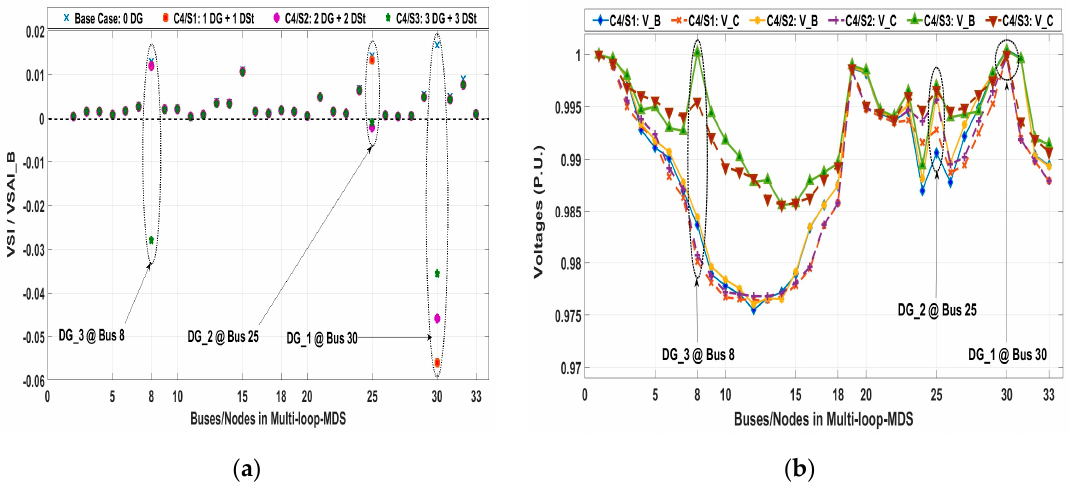
Figure 9. Case 4 for 33-bus MDS: DG (type-1) and DSTATCOM (type-3) equivalent to 0.90 ± 3% PF ( a ) VSAI_B trend, ( b ) V_B profile trend as feasible solution of VSAI_B and calculated V_C profiles.